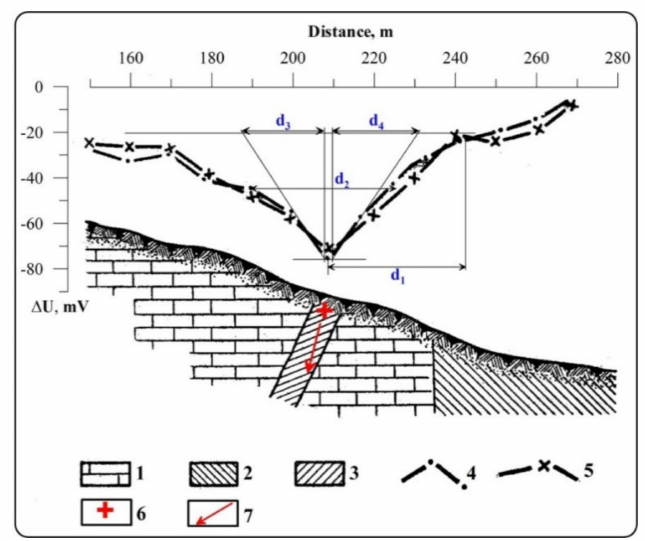
Figure 6. Quantitative interpretation of SP anomaly over polymetallic body (Rudnyi Altai, Russia). Observed SP curve and geological section ((1)–(5)) are taken from [3,37]. (1) limestone, (2) shales, (3) copper-polymetallic ore body, SP observations carried out in (4) 1952 and (5) 1953, (6) determined position of the center of the upper edge of the ore body, (7) direction of the self-potential vector.